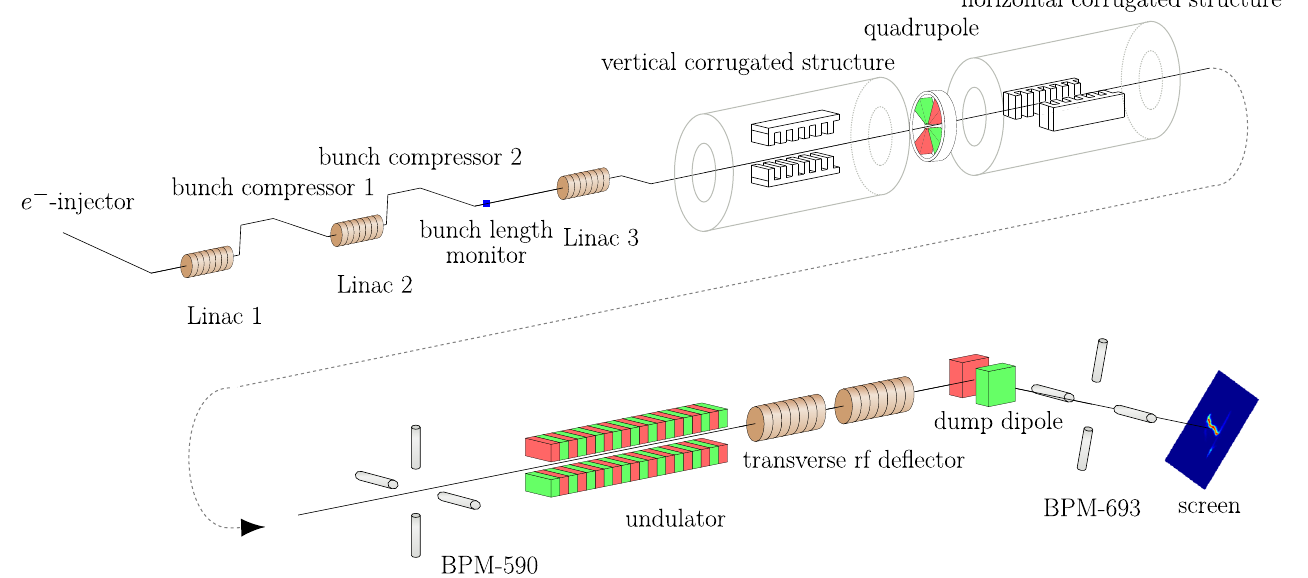
FIG. 2. Sketch of the LCLS beam line, focusing on the RadiaBeam/SLAC dechirper and the diagnostics used in the measurements of this report. Note that the relative scale of distances is greatly distorted; e.g., in reality the linacs are much longer than the other objects in the figure. During the measurements, the first, vertical dechirper module is kept wide open and the second, horizontal one ’ s effect on the beam is